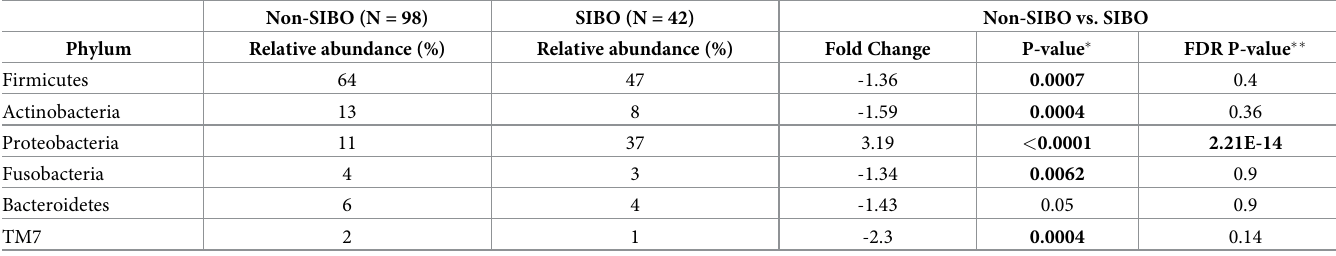
Table 3. Relative abundances of the top six phylae in the duodenal microbiomes of non-SIBO and SIBO subjects.